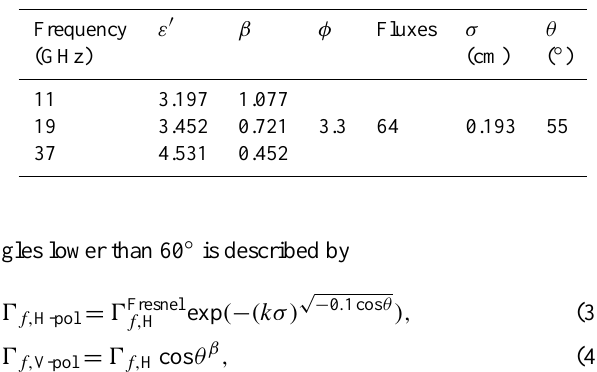
Table 6. Main parameters used in DMRT-ML.